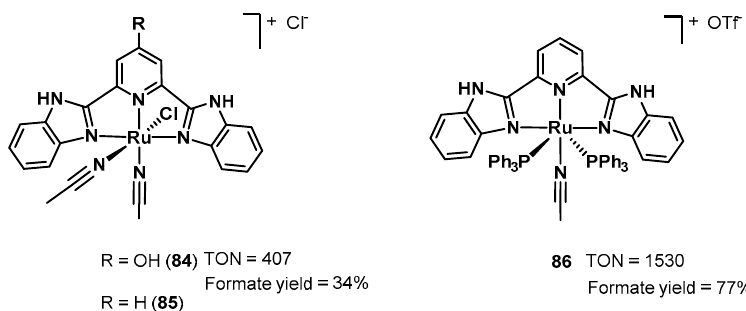
Figure 6. Ru-NNN pincer complexes synthetized and characterized by Peng and Zhang